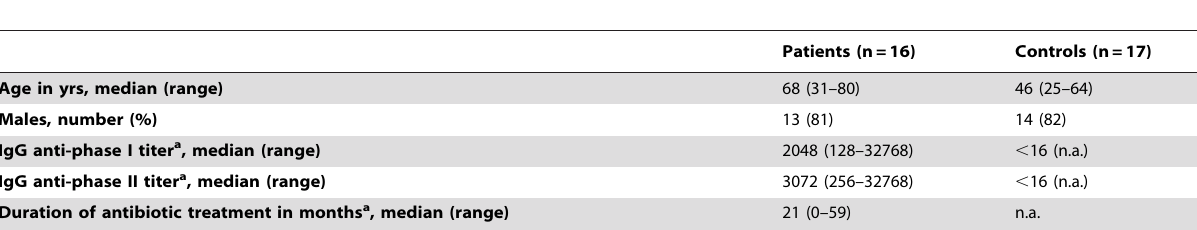
Table 1. Characteristics of chronic Q fever patients and control